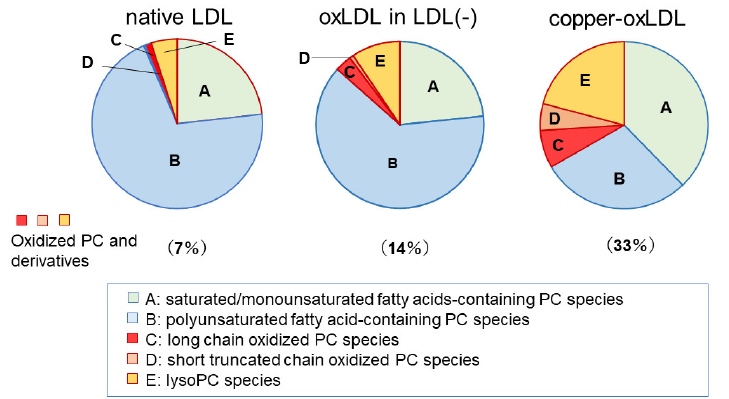
Figure 4. Composition of PCs in LDL, oxLDL recovered from LDL( − ) fraction, and copper-induced oxidized LDL. The LDL( − ) fraction was treated with anti-oxPC mAb to separate oxLDL from non- oxidized particles. PC molecular species were comprehensively analyzed by LC-MS/MS. More than 60 molecular species were classified into five groups: PC containing saturated and monounsaturated fatty acids ( A ), PUFA-containing PC ( B ), PC containing long chain oxidized fatty acids ( C ), oxPC con- taining truncated fatty acids ( D ), and lysoPC ( E ). The data are summarized from references